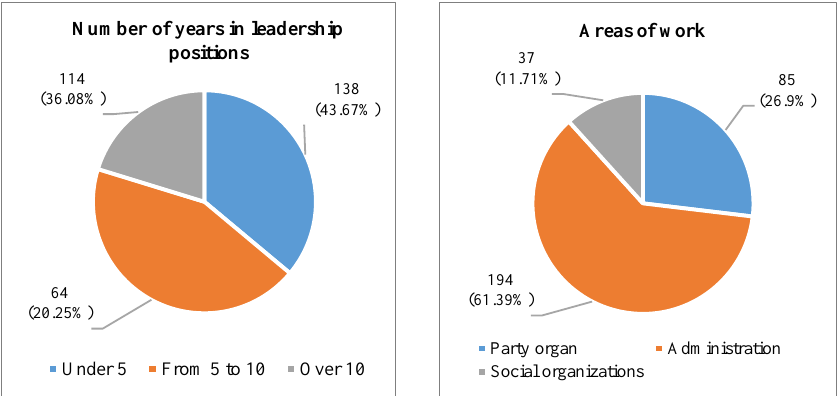
Figure 4. Descriptive statistics of the sample by the areas of training.